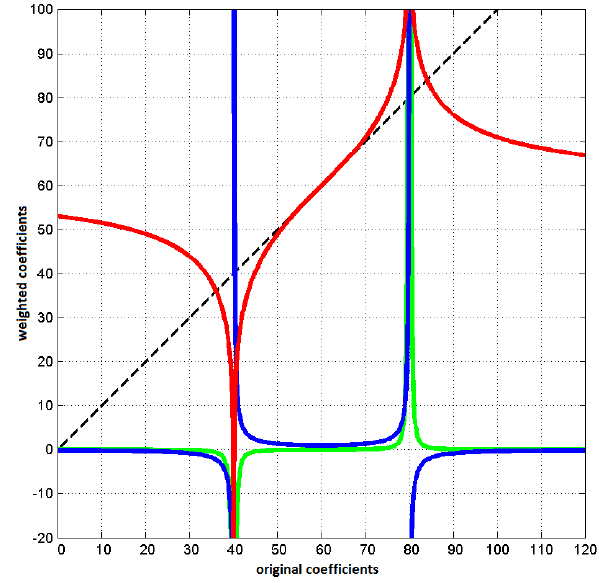
Figure 9. Modified Area Hyperbolic Tangent function (red), gradient (blue) and curvature (green) for a = 40 and b =